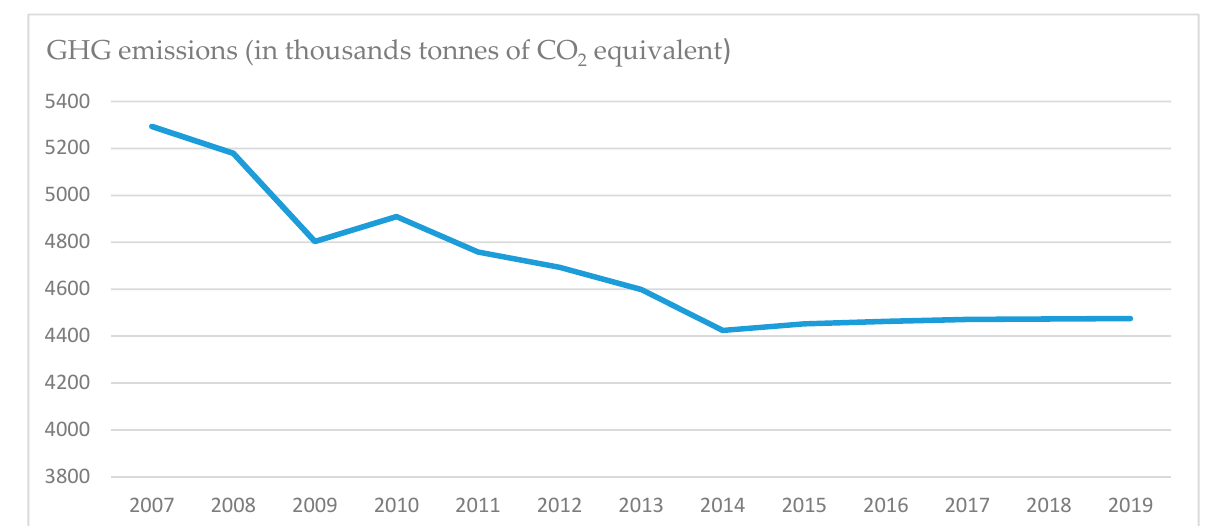
Figure 1. GHG emissions in thousands tons of CO 2 equivalent in the EU-28 countries (2007–2019).